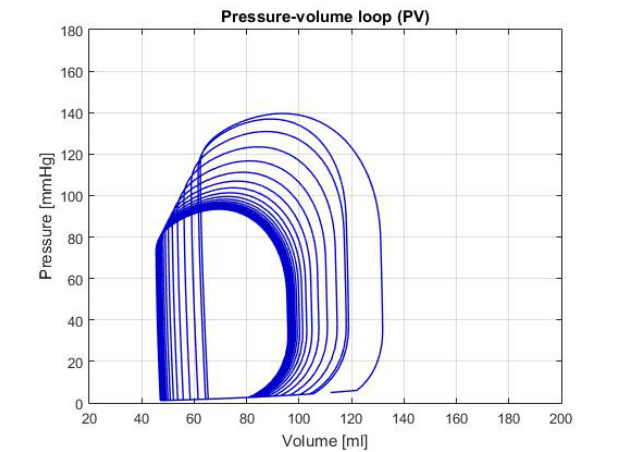
Figure 6. Graph of P-V loop curves with Diastolic Heart Failure (DHF).